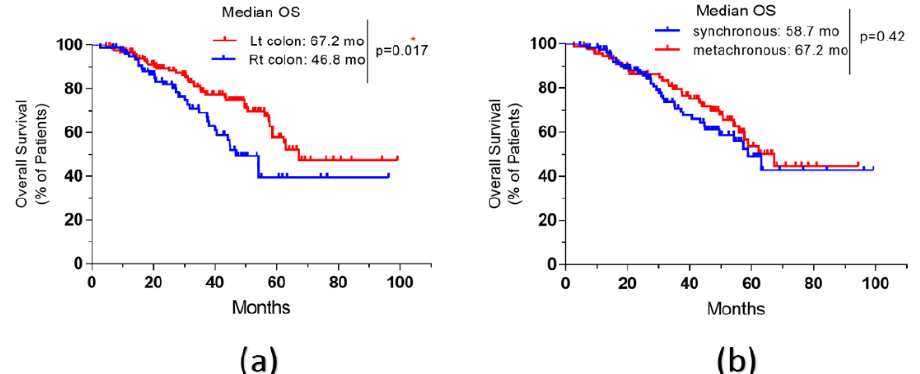
Figure 2. Survival curves of older patients with CRLM according to some identified factors. ( a ): overall survival (OS) of patients with right-sided primary compared to left-sided, Rt: Right; Lt: Left. ( b ): overall survival (OS) according to the timing of CRLM, synchronous versus metachronous; *: significant p -value.